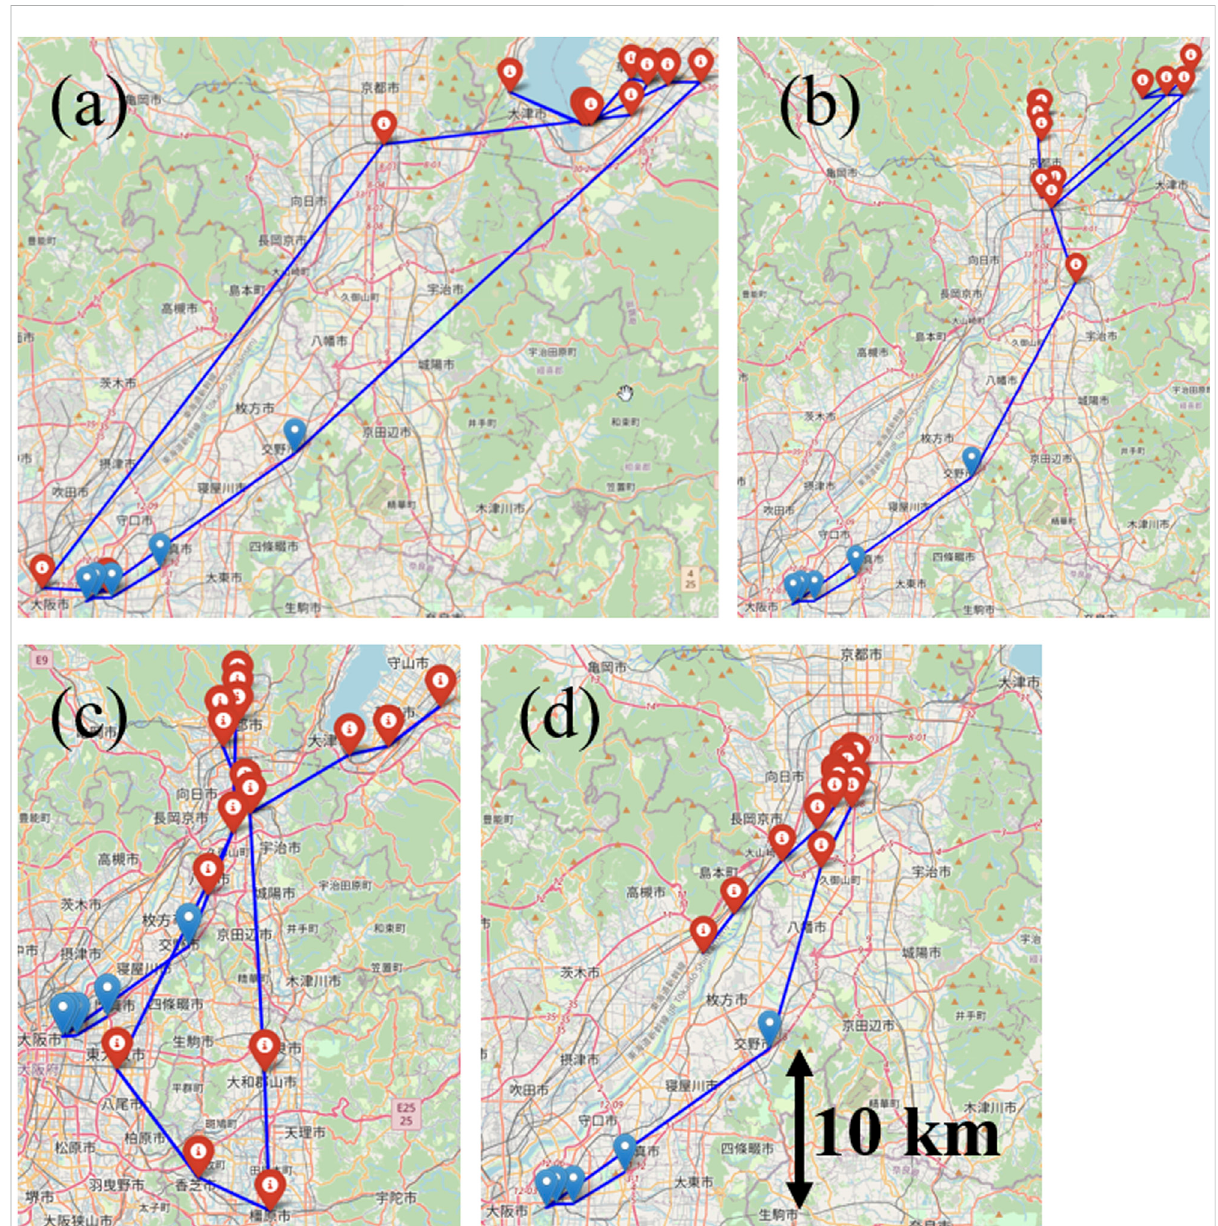
FIGURE 2 Examplesofmodel-generatedindividualdailytrajectoriesfromthesameinput: (A) GPT-2, (B) 2-g, (C) 3-g, (D) Multi-OutputCatboost.Blueand red icons represent inputs and outputs, respectively. The maps were created using